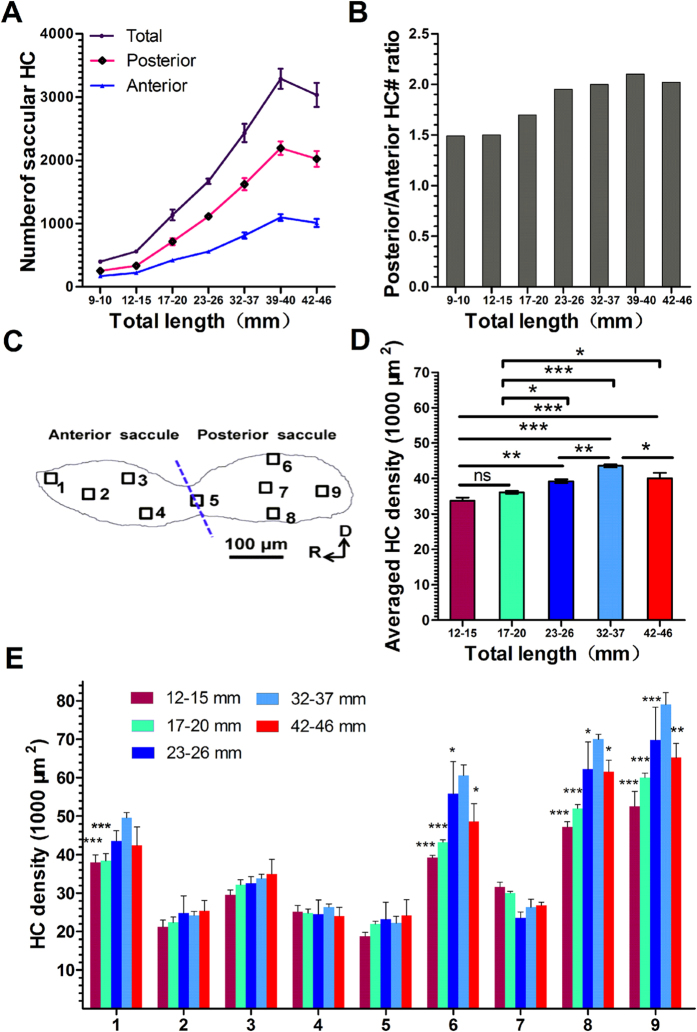
Developmental changes in HC number and density.(A) Differences in HC number according to TL for the total (including posterior and anterior) and separated posterior and anterior saccule regions across the 7 TL groups, from 9 to 46 mm (n = 5–8 in each group). (B) The ratio of the HC number in the posterior saccule to that in the anterior saccule as a function of TL. (C) Regional divisions of the saccule. (D) HC densities were compared across TL groups using post hoc tests. A significant TL effect was revealed by one-way ANOVA (P < 0.001). (E) Comparison of TL-related HC density changes across different regions and TL groups. One-way ANOVA was performed for TL for each region, and a significant difference in HC density according to TL was observed in the four marginal regions (1, 6, 8 and 9; P < 0.001) but not in the central regions (2, 3, 4, 5 and 7; P > 0.05). Post hoc tests were performed to compare the HC of the 32–37 mm group for each region. *P < 0.05, **P < 0.01, ***P < 0.001.